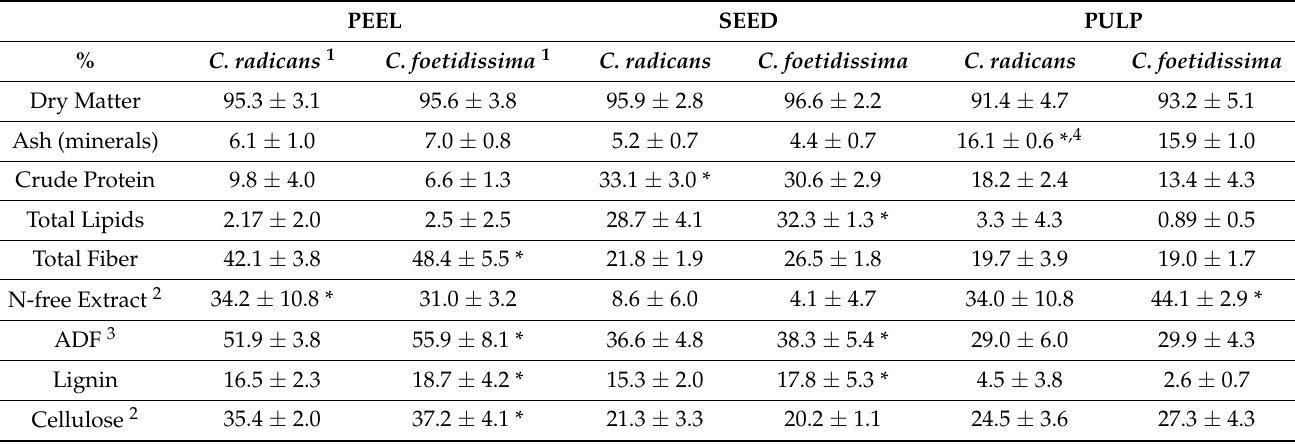
Table 2. Proximal composition in Cucurbita foetidissima and C. radicans fruits. Proximal composition variables were measured in fruits of C. foetidissima and C. radicans plants collected in the wild from sites localized in the state of Jalisco,